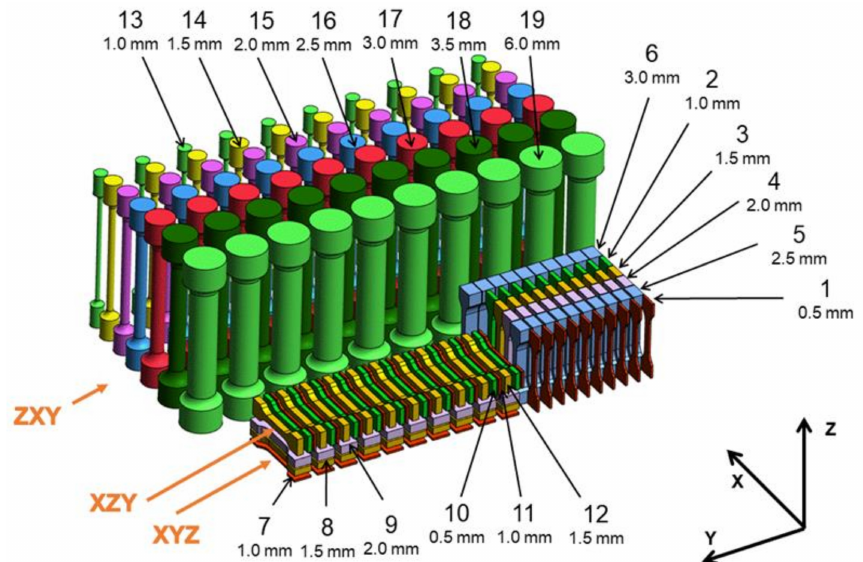
Figure 1. Deposition scheme for the EBM-processed samples. The number designations denote both the sample group and the size, i.e., diameter or thickness for the round and the flat specimens, respectively. A similar scheme was utilized for the SLM-processed samples summarized elsewhere.